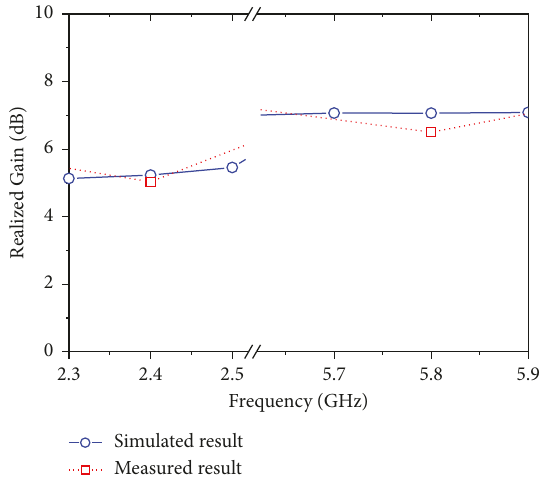
Figure 8: Simulated and the measured realized gain over the operating bands of the proposed directional antenna.